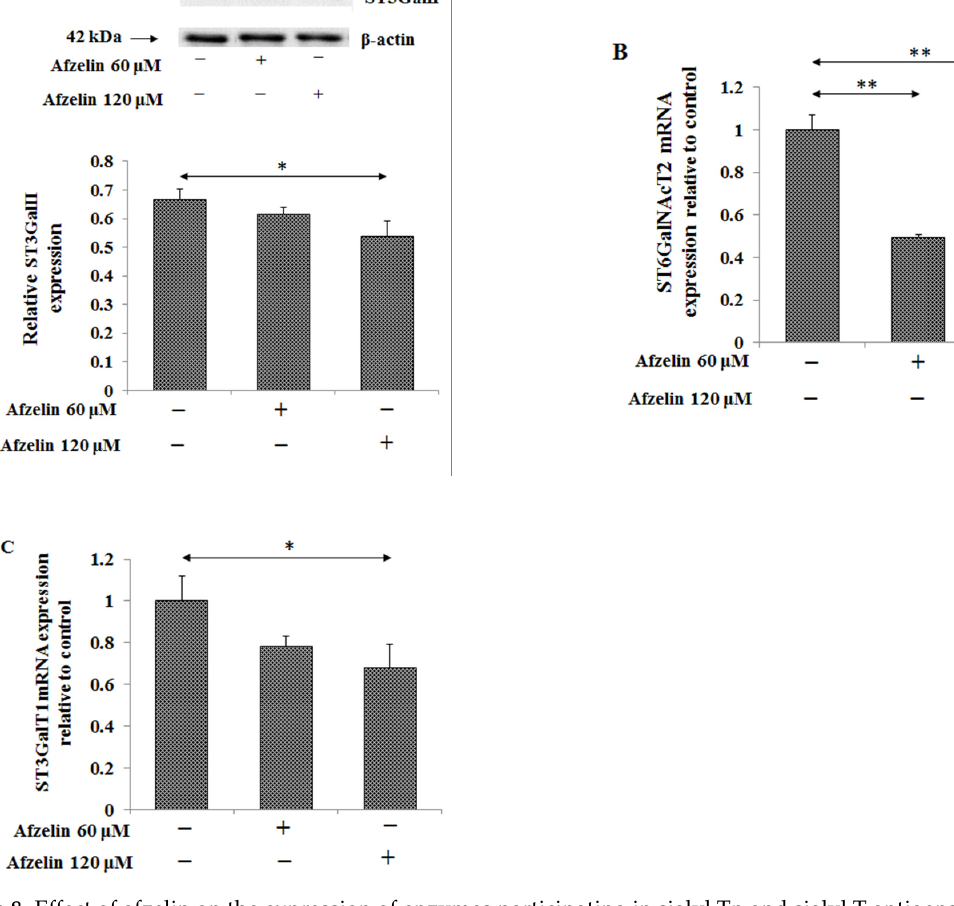
Figure 8. Effect of afzelin on the expression of enzymes participating in sialyl Tn and sialyl T antigens formation in AGS gastric cancer cells treated with 60 or 120 µ M afzelin. Expression of ST3GalII ( A ) in cell lysates was measured using Western blot analysis. The β -actin expression served as protein loading control. The bands intensity was quantified by densitometry. Data are presented as the mean ± SD from 3 assays. * p < 0.05; ST6GalNAcT2 ( B ) and ST3GalT1 ( C ) gene expressions were assessed by RT-PCR. The results are expressed as a relative fold change in ST6GalNAcT2 and ST3GalT1mRNA expression in comparison to control where expression was set as 1. ± SD are the mean of triplicate cultures. * p < 0.05; ** p < 0.01.